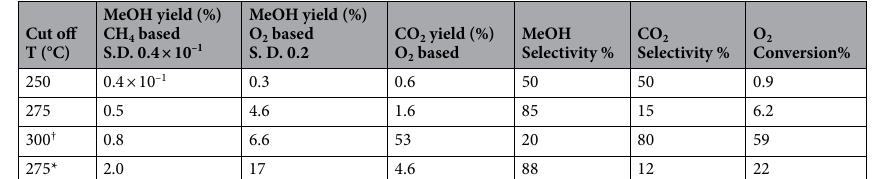
Table 1. The effect of temperature on direct methane oxidation to methanol in near supercritical acetonitrile. *With 400 mg h -BN (2.30: 1 h-BN: oxygen molar ratio), all other runs were conducted with 3 mL acetonitrile, 7 mmol of O 2 , 118 mmol of CH 4 , and 163 mmol He. All gases were cold fed to a total of ~ 1570 psi at − 30 °C. The reactor was heated at a 2.5 °C/min ramp rate to 275 °C. The heater cut off was set at 275 °C (no dwell time). The stirring speed was set at 60 rpm. The reactor was cooled to ambient at the natural convection rate. Standard deviations (S. D.) were based on deviations in loading pressure. Methanol yield was calculated based on a GC peak area calibration plot and reconfirmed with NMR. The standard deviation of the yield was calculated by replicating one experiment and comparing those data to NMR data. Small amounts of acetamide and acetic acid were formed as hydration products of acetonitrile and for simplicity purposes those products were excluded from the calculations. † Higher tendency towards formation of acetamide and acetic acid relative to other reaction conditions was observed. As based on the GC traces these products were formed in negligible amounts for entries 1, 2 and